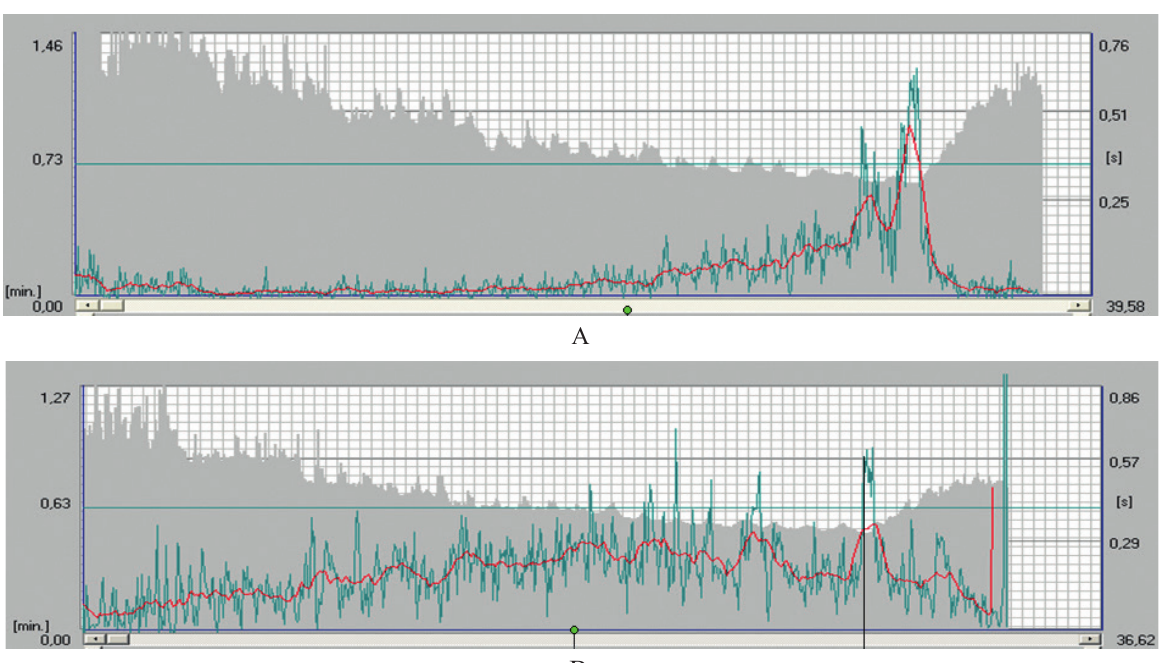
Figure 4. Dynamics of discriminants between RR intervals and QRS during incremental exercise test and recovery of elite athlete (A) and other athlete with medical diagnosis “Overtraining”(B). Notes. X axis – discriminant value (left); RR intervals, s (right). Y axis – time, min Grey (background) shows dynamics of RR intervals of ECG; Green line – discriminant; red line – discriminant averaged of 10 figures.